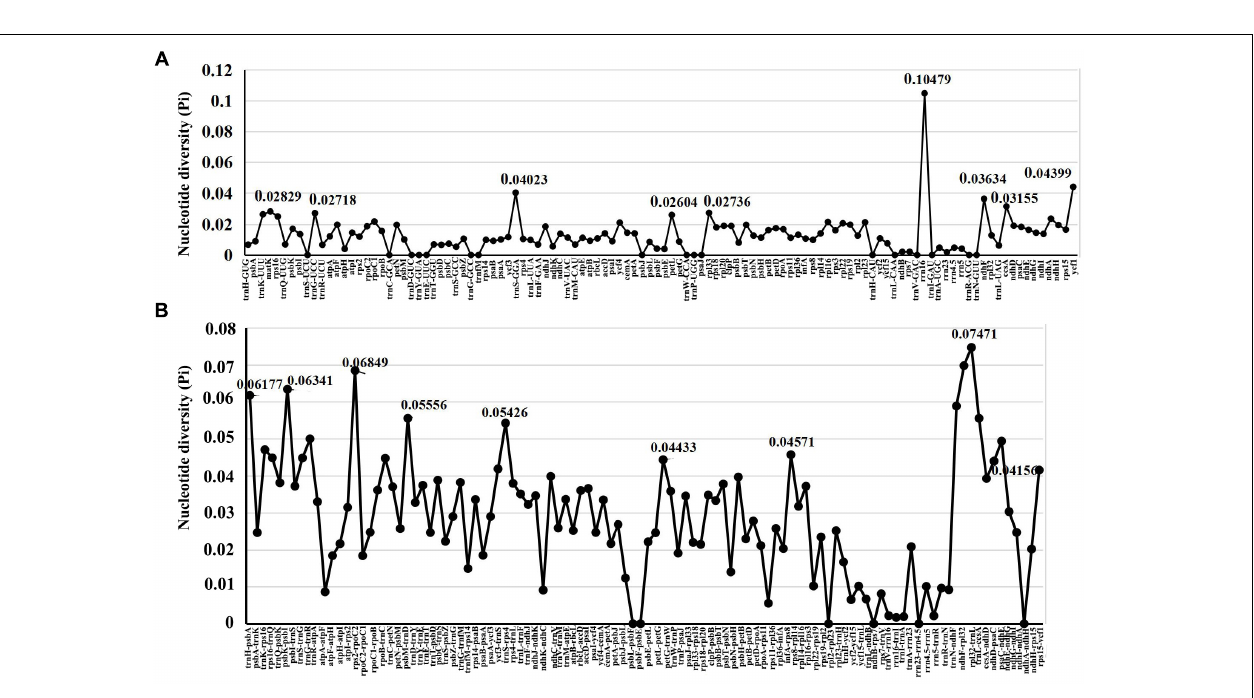
Frontiers in Plant Science |